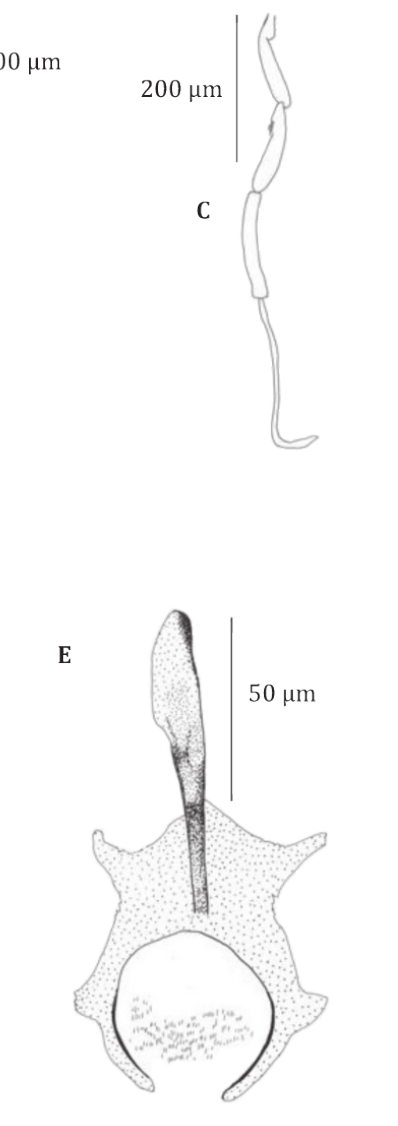
Fig. 2. – S. pessoni n. sp. female. A: pharynx and cibarium; B: antennal segments III, IV and V; C: palp; D: spermathe- cae; E: